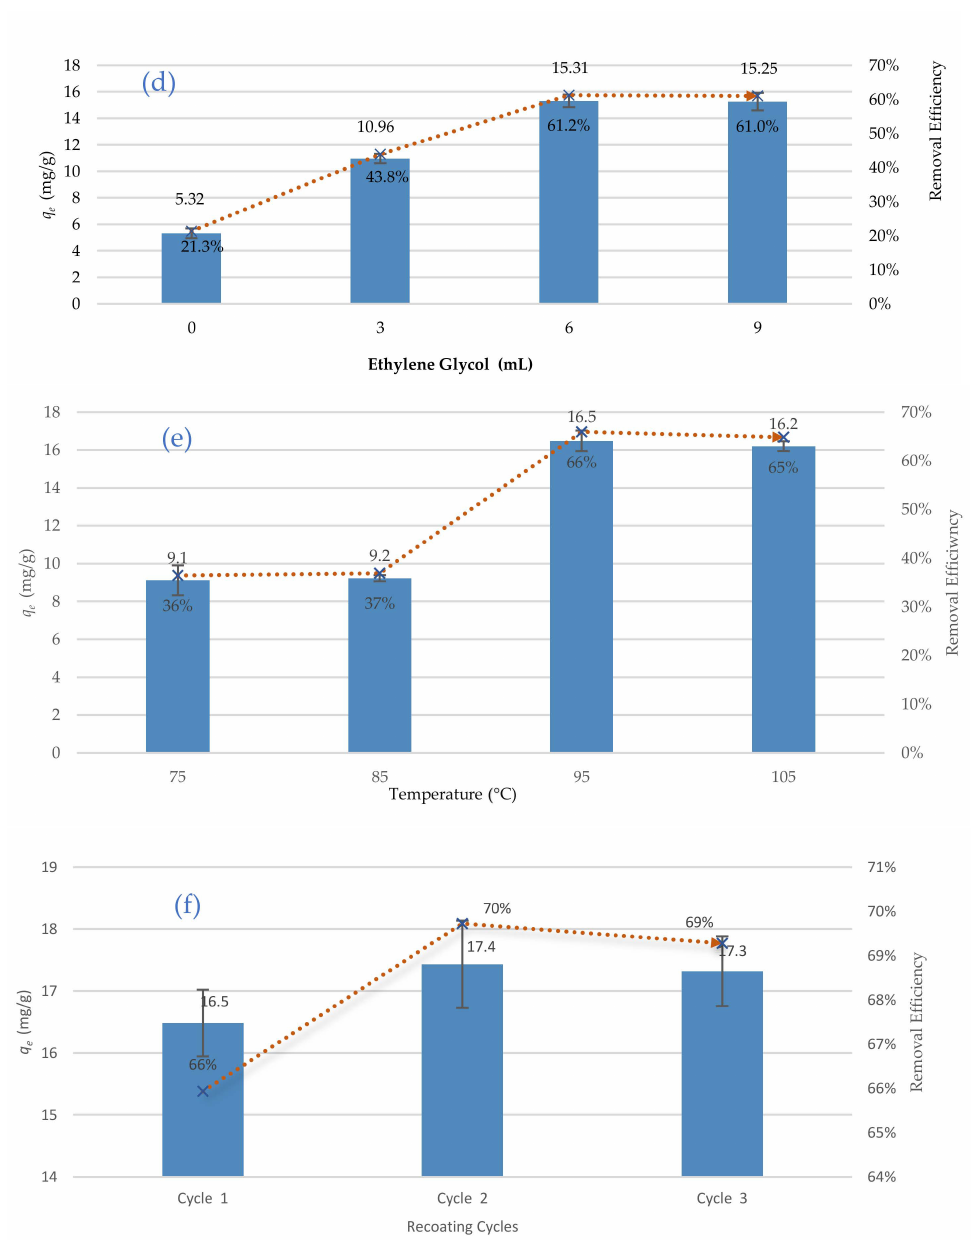
Figure 6. The removal efficacy, average ( q e ) for, ( a ) different Fe/Ca molar ratio, ( b ) different silica sand percentages, ( c ) different pH values, ( d ) different Ethylene glycol values, ( e ) different drying temperatures, ( f ) multi recoating